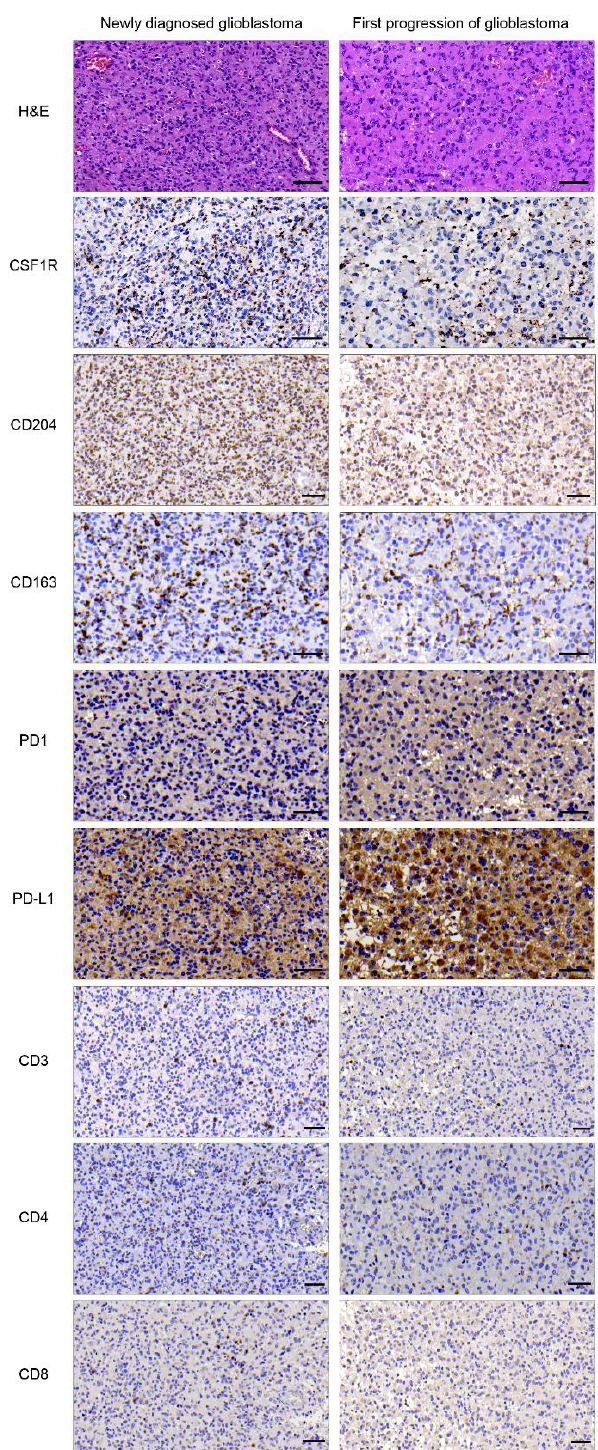
Figure 1. CSF1R and PD1 are present in primary and progressive glioblastoma. Representative tumor areas from matched pairs of newly diagnosed and progressive glioblastoma. H&E staining (top row) and immunohistochemical staining of CSF1R ( n = 28), CD204 ( n = 27), CD163 ( n = 31), PD1 ( n = 30), PD-L1 ( n = 31), CD3 ( n = 28), CD4 ( n = 30), and CD8 ( n = 28). Scale bars 50 µm.